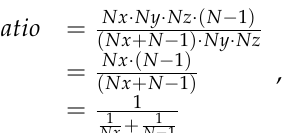
Figure 7. Illustration of the computation procedure for Equation (23) (symbols y , z and t are omitted).